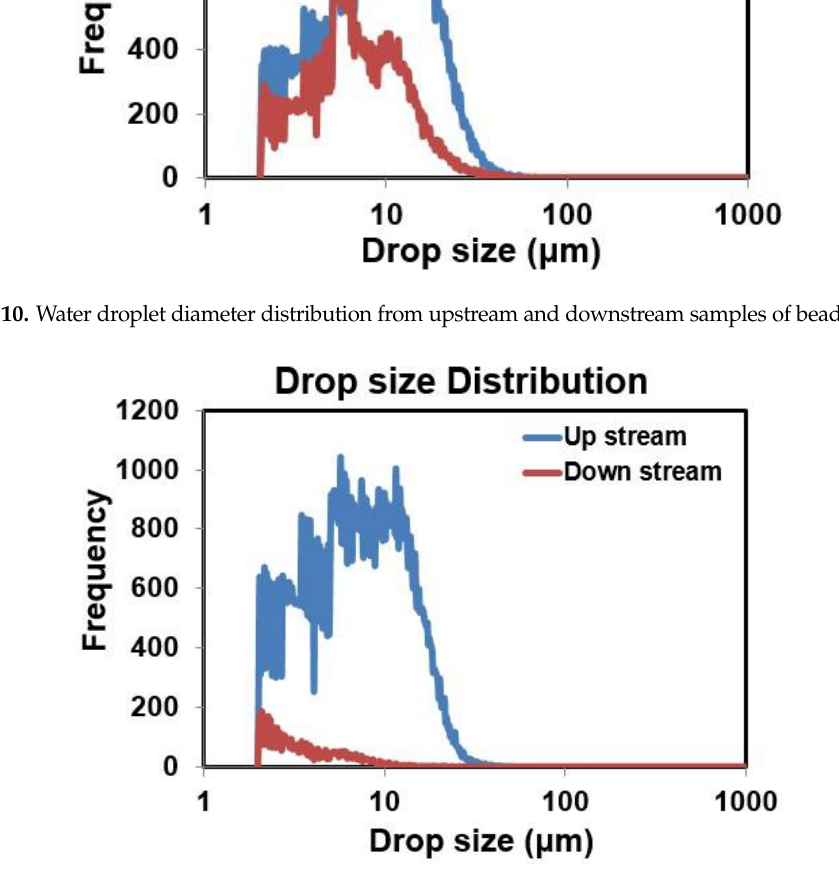
Figure 11. Droplet diameter distribution from upstream and downstream samples of non-beaded fibers.